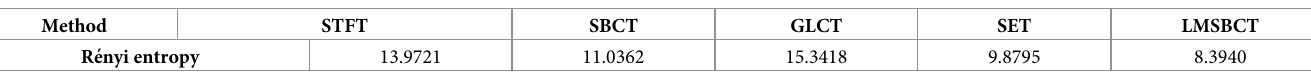
Table 3. Re´nyi entropy of different